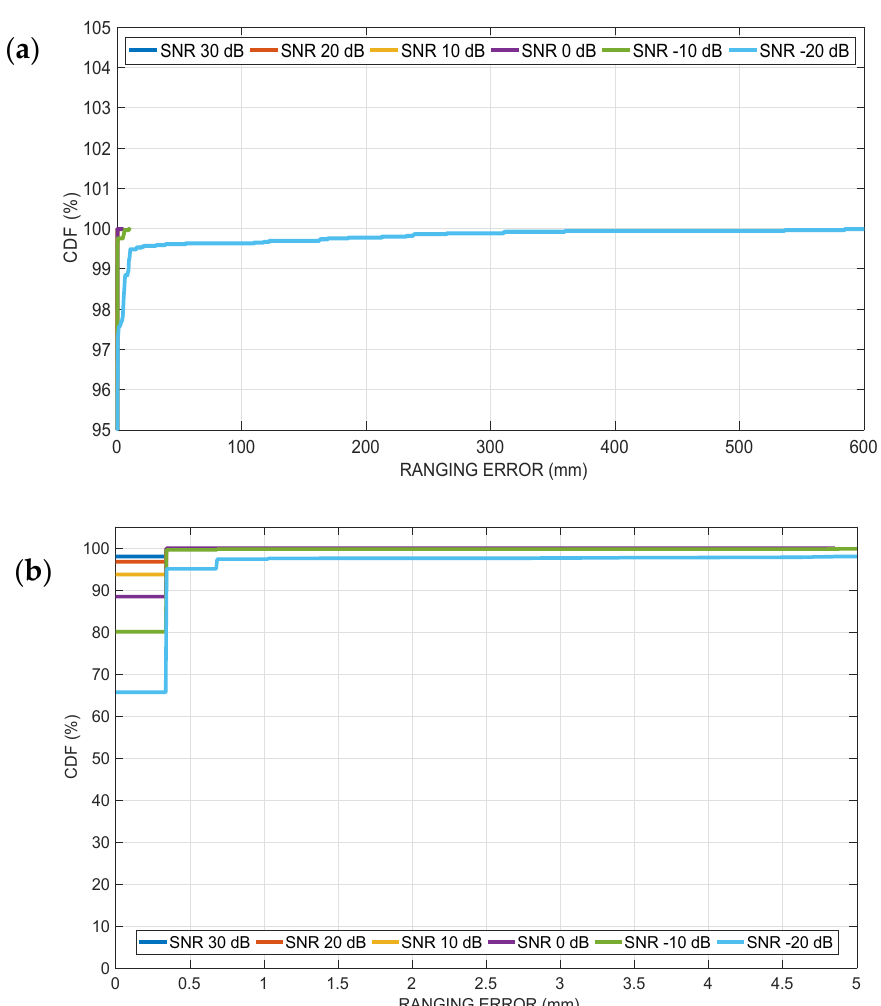
Figure 4. Numerical results at different SNR levels using a linear chirp 30–50 kHz. A linearized air absorption around 40 kHz has been assumed: ( a ) cumulative distribution function (percent of readings with error less than the value of a given abscissa) of the ranging error along the vertical section A of Figure 1, for decreasing SNR levels from 30 dB down to -20 dB ( y -axis zoomed), ( b ) x -axis zoomed portion of the cumulative distribution function in the range 0-5 mm.